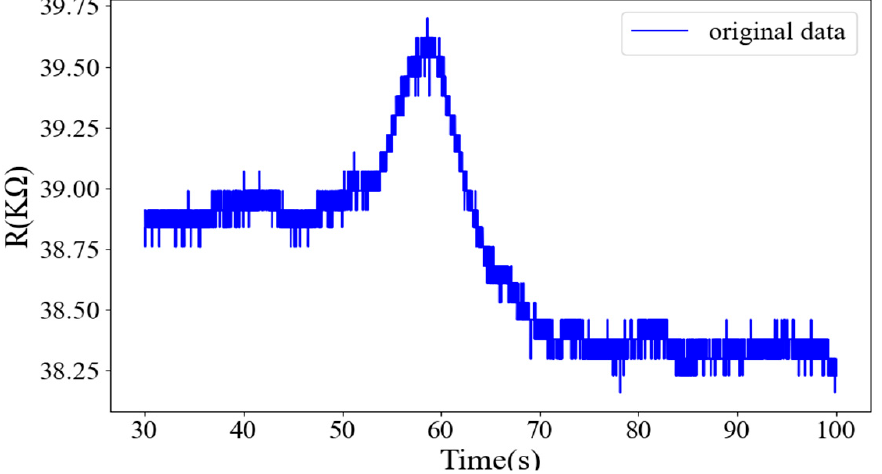
Figure 3. The original response data curve of CO gas.